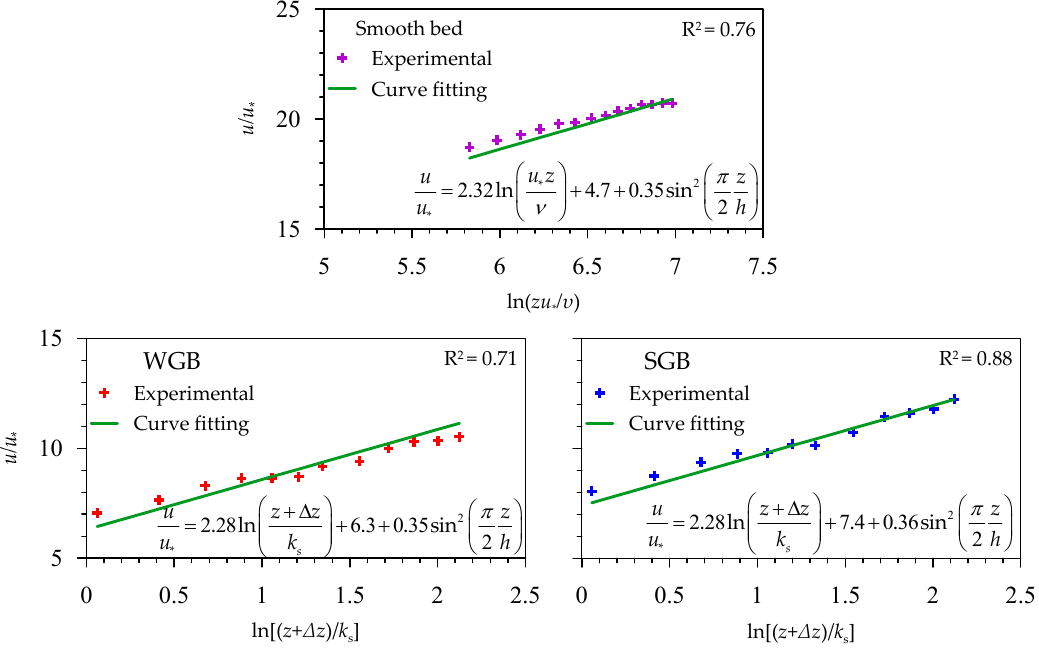
Figure 7. Variations of non-dimensional streamwise velocity with non-dimensional vertical distance zu * / ν and ( z + ∆ z ) / k s in smooth and rough beds (WGB and SGB), respectively (data extracted from Pu et al. [30]).